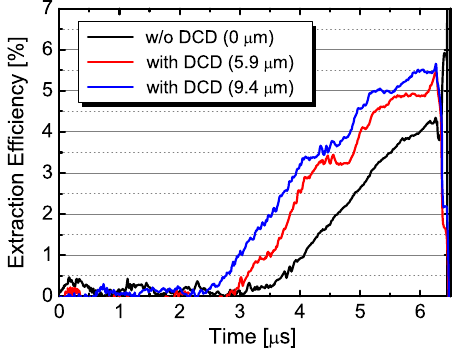
FIG. 8. Evolutions of the extraction efficiency with different DCD parameters evaluated from the evolutions of the energy distribution of the electron beam.